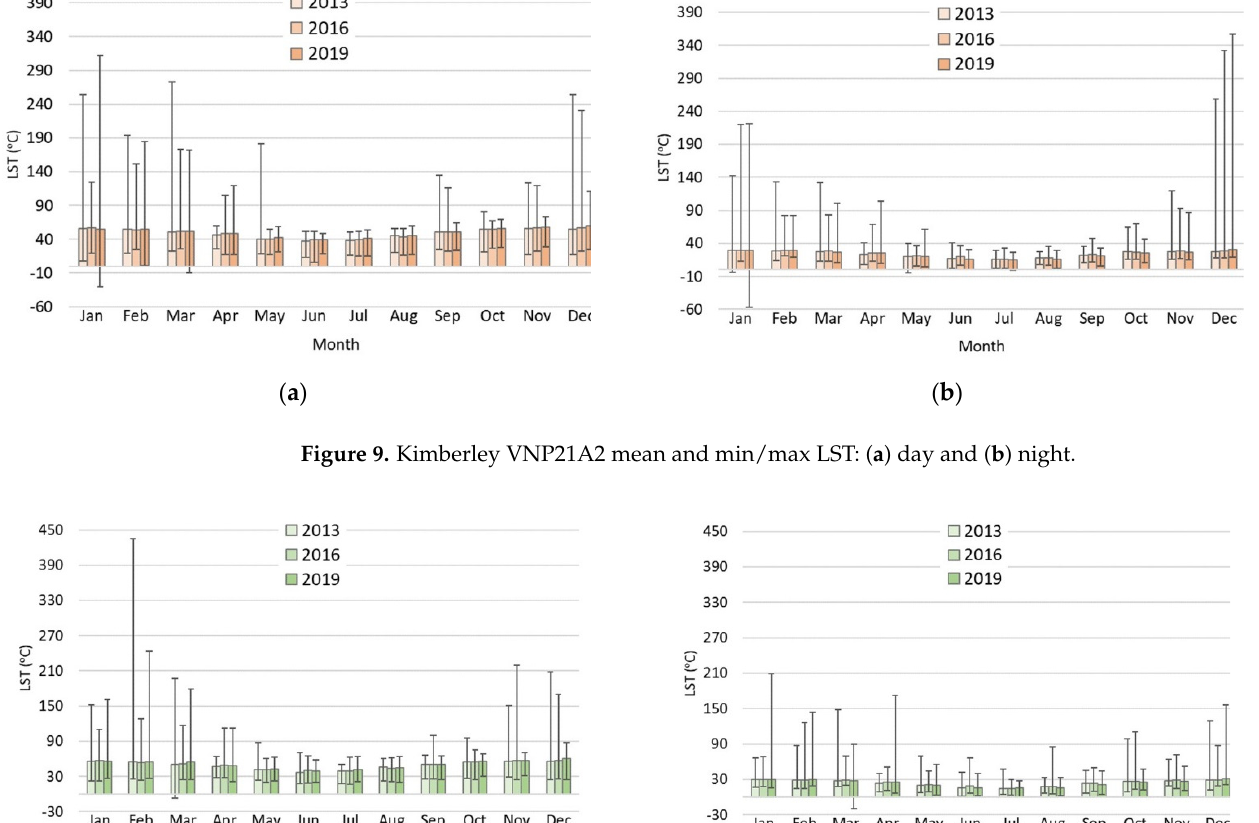
Figure 10. Kimberley MYD21A2 mean and min/max LST: ( a ) day and ( b ) night. A boxplot of the yearly diurnal LST values calculated from the monthly data is shown in Figure 11.